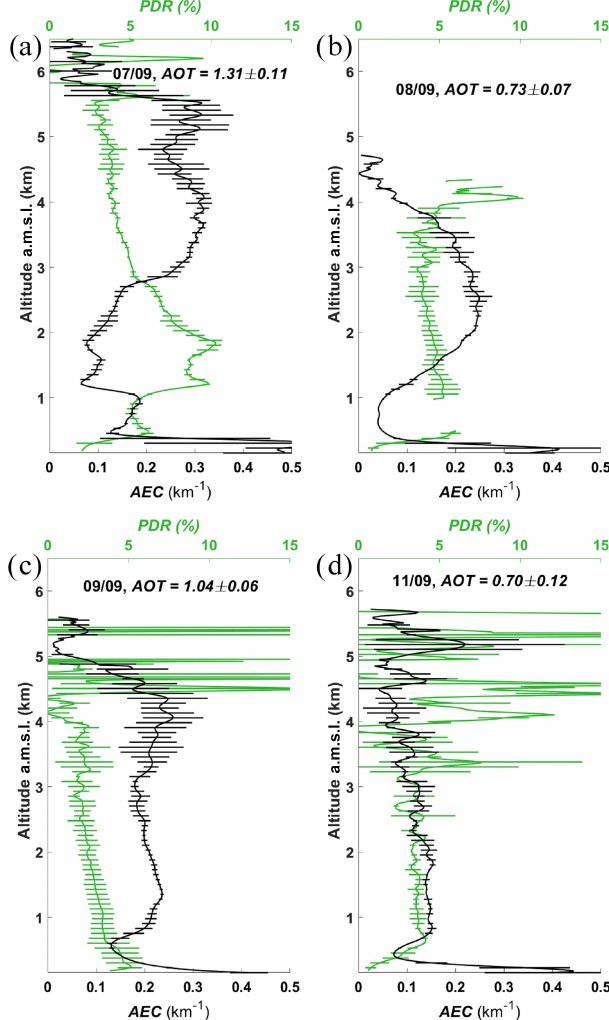
Figure 7. Vertical profiles of the AEC and PDR at 355nm with their uncertainties (horizontal bars) for period P 3 on (a) 7 (16:00– 19:00UTC), (b) 8 (13:00–15:00UTC), (c) 9 (09:00–12:00UTC) and (d) 11 (10:40–11:40UTC) September 2017. The total AOT at 355nm is also given for each profile with its